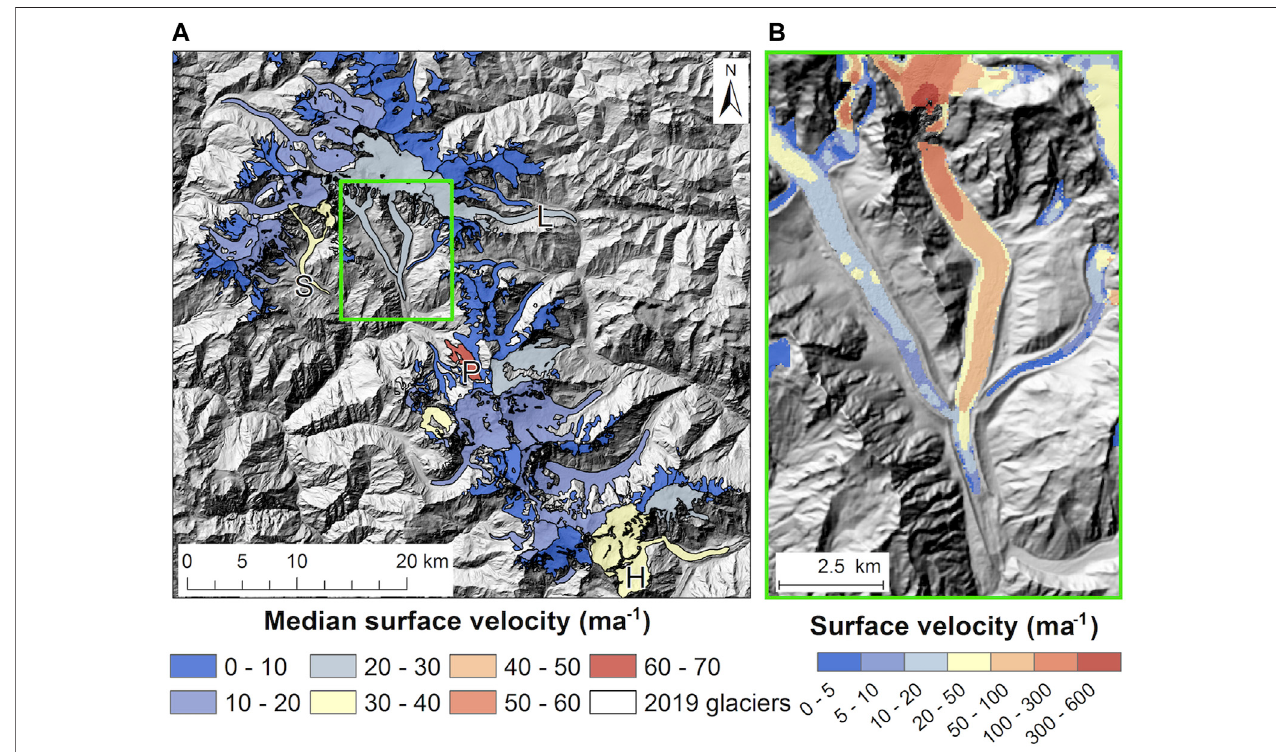
FIGURE7| Surface fl owvelocityofglaciersintheManasluregionbetween2017and2018colorcodedfromblue (lowvelocity) tored (highvelocity) : (A) Median surfacevelocitycalculatedoverthe2019glacierboundarieswithglaciersdiscussedinthetext:S — SutiGlacier,L — LarkyaGlacier;H — HimalChuliGlaciersandP — Purdi Glacier; thegreen rectangle represents the extent ofPonkar Glacier complexfrom Figure 9 ; (B) Zoom onthesurface fl owvelocity map ofthe PonkarGlacier overlaid on AW3D30andHMADEMshadedrelief.Missingvelocitydataattheupperpartofthemiddletributaryin(b)correspondtoareaswherethevelocitywasnotcaptured by the feature tracking algorithm (Millan et al.,